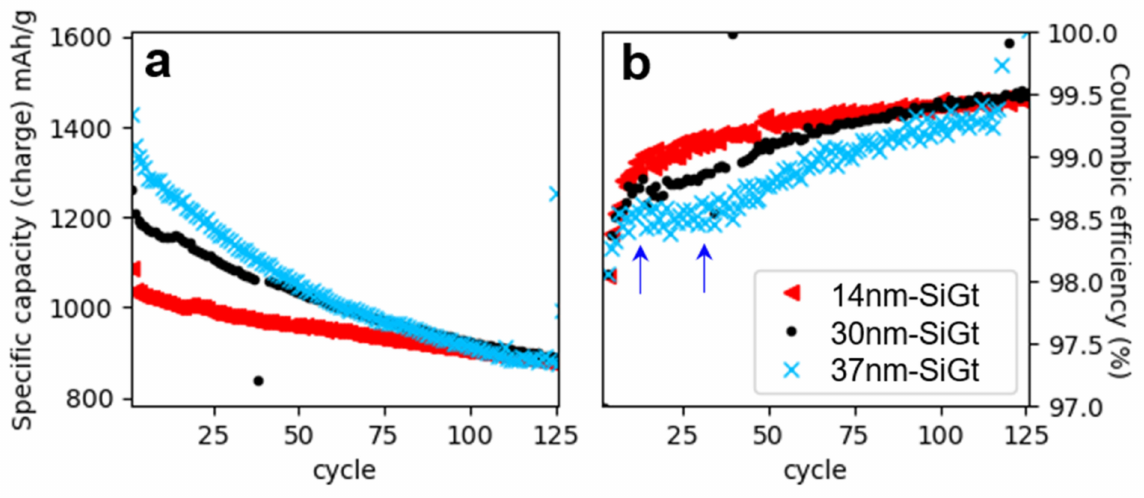
Figure 5. Long-term cycling of SiGt at rate C/5 between 1 and 0.01 V: specific capacity ( a ) and Coulombic efficiency ( b ) vs. cycle number for 14 nm–SiGt (triangles), 30 nm–SiGt (dots) and 37 nm– SiGt (crosses). Arrows highlight the cycles during which the Coulombic efficiency plateaus for 37